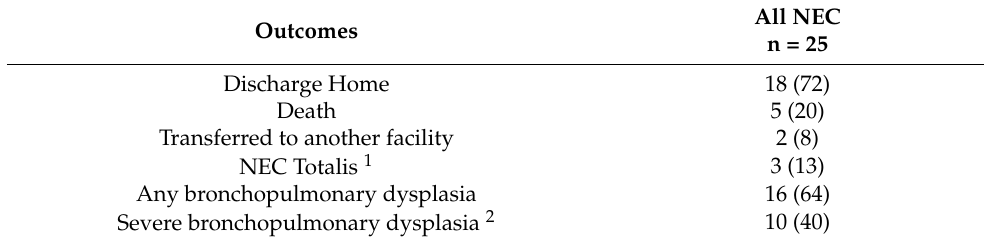
Table 5. Outcomes: All